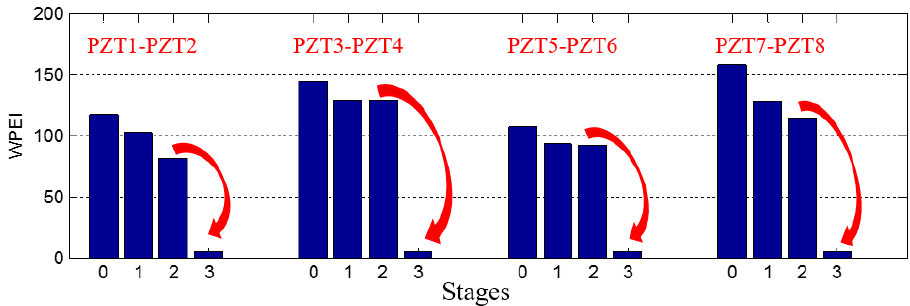
Figure 10. Wavelet packet-based energy indices.